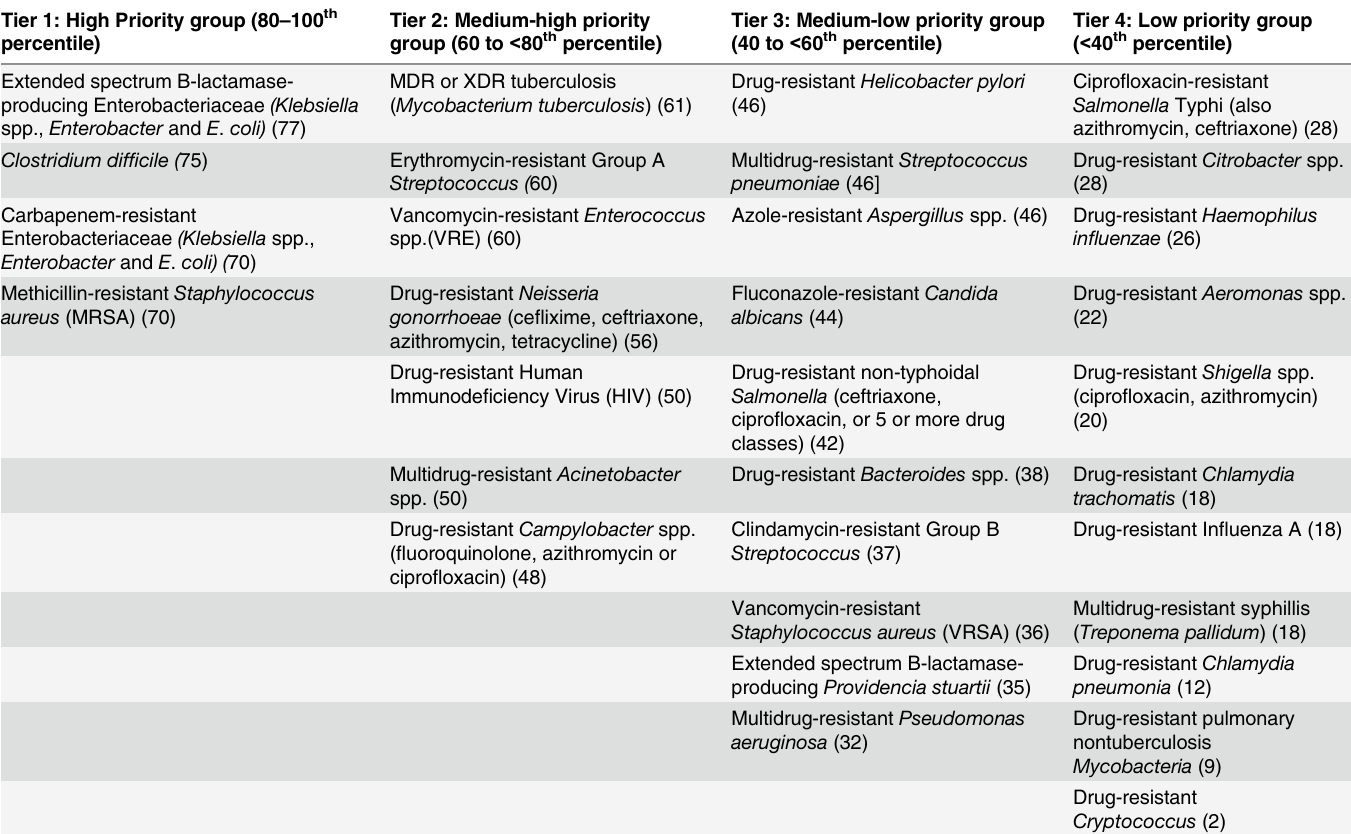
Table 2. List of AMR pathogens by priority group, based on total risk score (n = 32) Public Health Agency of